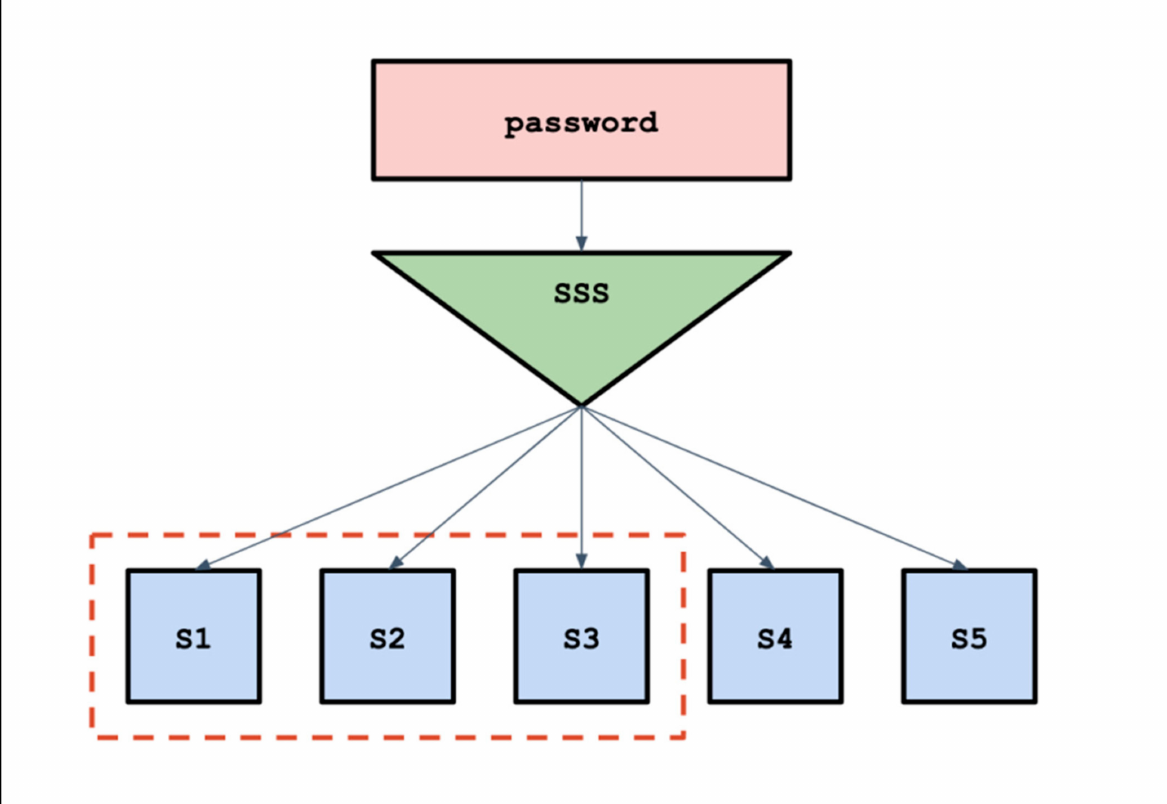
Figure 3. Shamir Secret Sharing for N = 5 and T =